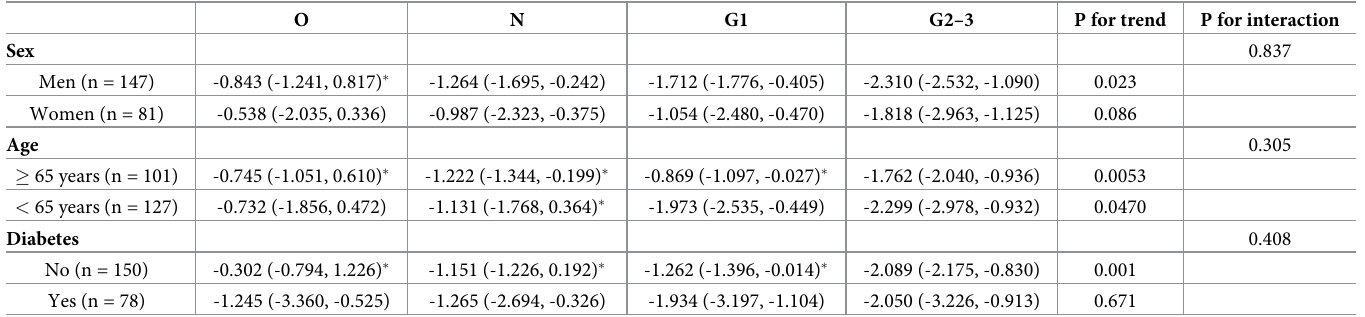
Table 3. Multivariable-adjusted mean decline rate of RKF with 95%CI in the subgroups of BP 3M category. O N G1 P for trend P for